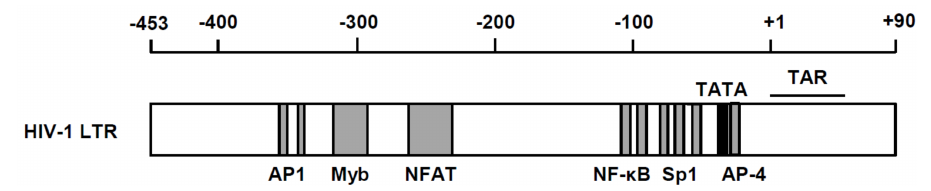
Figure 1. Cis-acting regulatory elements in the HIV-1 LTR. Binding sites for AP-1 (nucleotide positions: − 350 to − 343 and − 336 to − 330), Myb ( − 314 to − 293), NFAT ( − 274 to − 218), NF- κ B ( − 105 to − 96 and − 91 to − 82), SP-1 ( − 78 to − 69, − 67 to − 58 and − 56 to − 47) and AP 4 ( − 22 to − 17) are indicated as gray boxes. Positions of the TATA box ( − 27 to − 24) and TAR region (+1 to +59) are shown as a black box and black line, respectively.